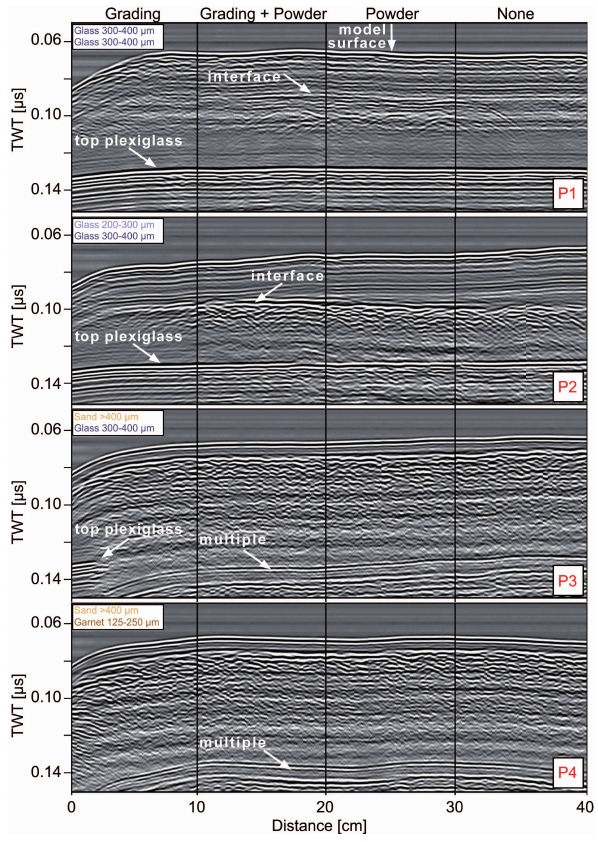
Fig. 6. Reflection seismic sections across the interface model lo- cated at lines P1–P4 given in Fig. 5. The interface is best imaged when it is prepared by grading and powder as well as between well- rounded and well-sorted glass beads (P1, P2).